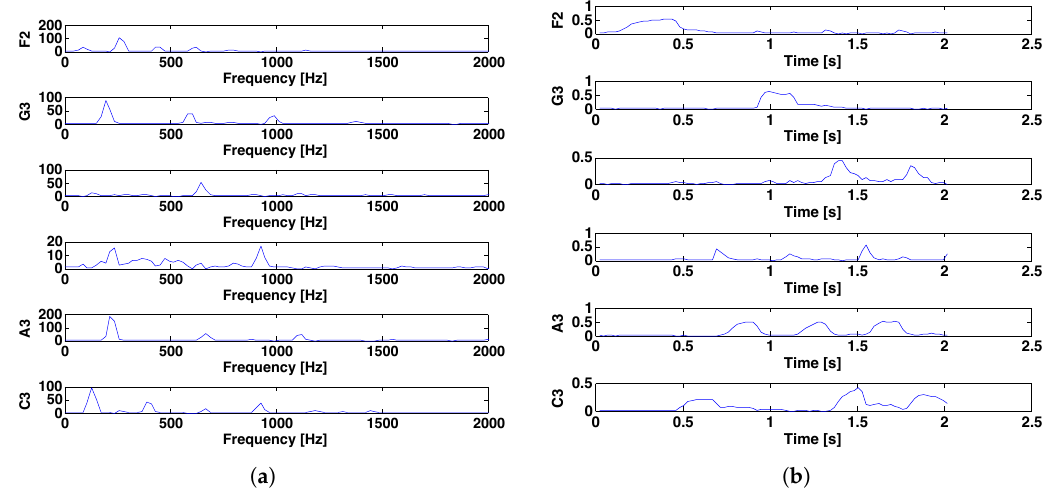
Figure 3. Example of NMF analysis for ( a ) the column vectors of W and ( b ) the row vectors of H , when the number of basis vectors is excessively large.